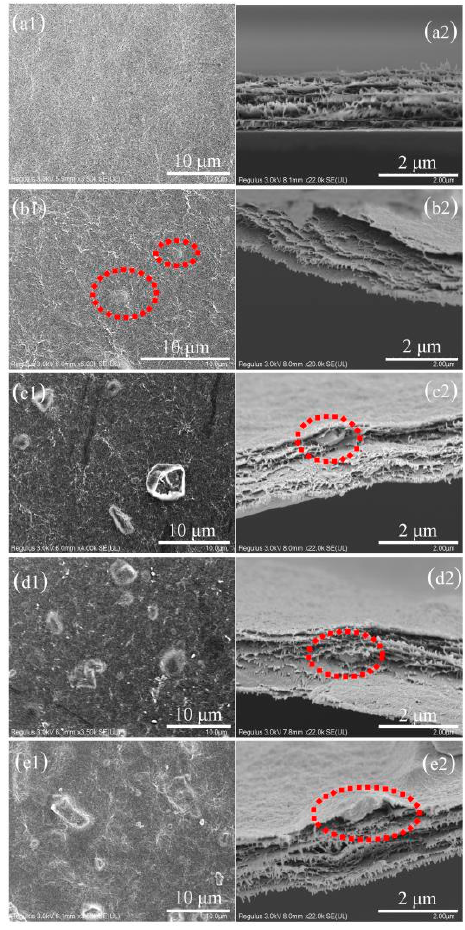
Figure 3. SEM observations of membrane surface ( a1 – e1 ) and cross-sectional morphology ( a2 – e2 ): ( a1 , a2 ) Kevlar, ( b1 , b2 ) 2.5% nano-BC/Kevlar, ( c1 , c2 ) 5% nano-BC/Kevlar, ( d1 , d2 ) 7.5% nano- BC/Kevlar, and ( e1 , e2 ) 10% nano-BC/Kevlar.